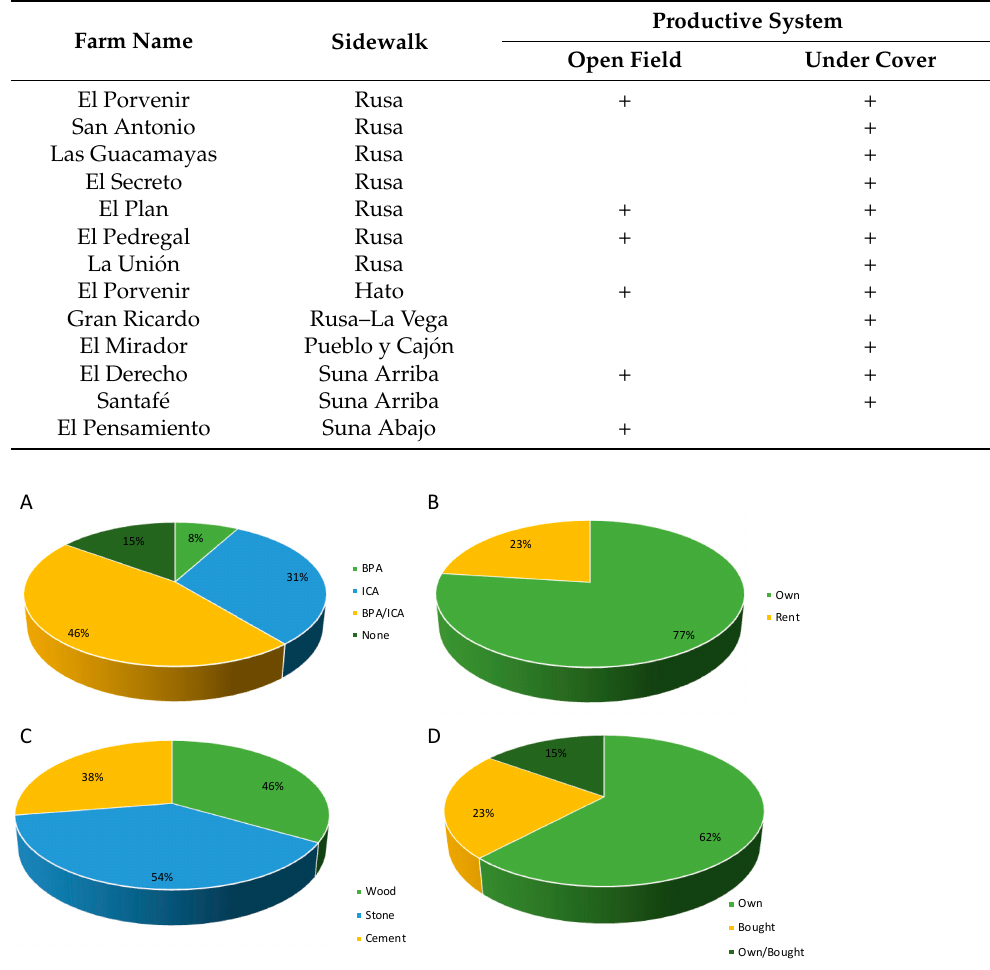
Figure 1. Survey responses from 13 producers in the municipality of Miraflores for the diagnostic census: ( A ) certification level; ( B ) land tenancy; ( C ) materials used by the producers for the construction of plant trellises; and ( D ) origin of the material planted on the farms.